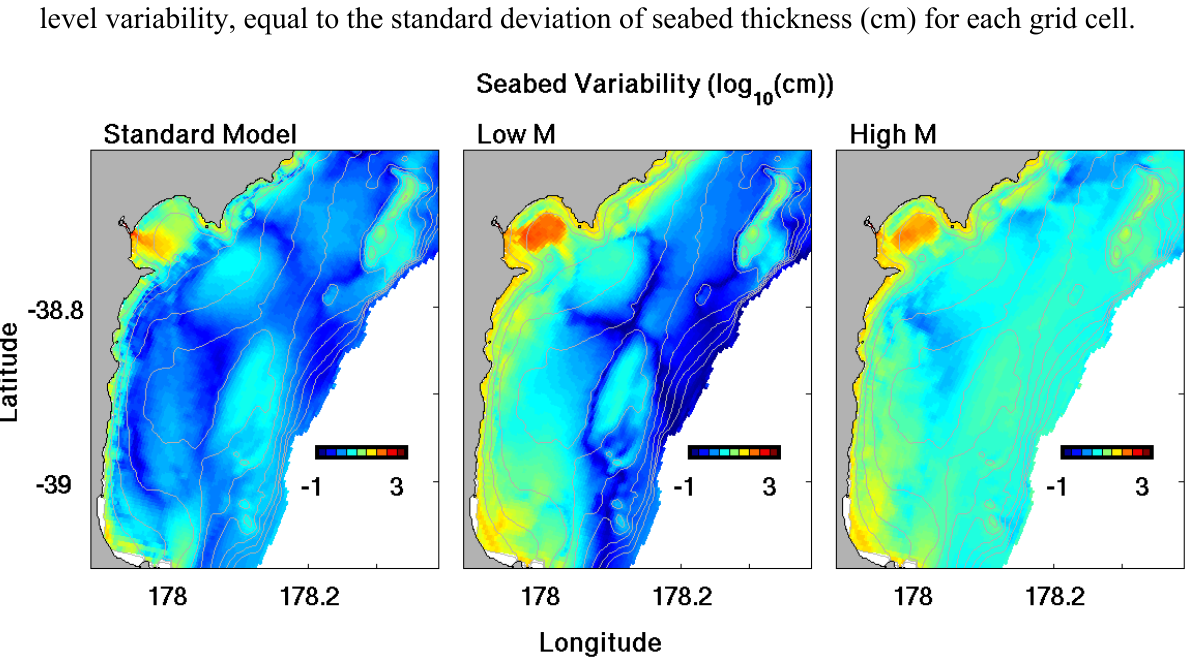
of the modeled seabed 10